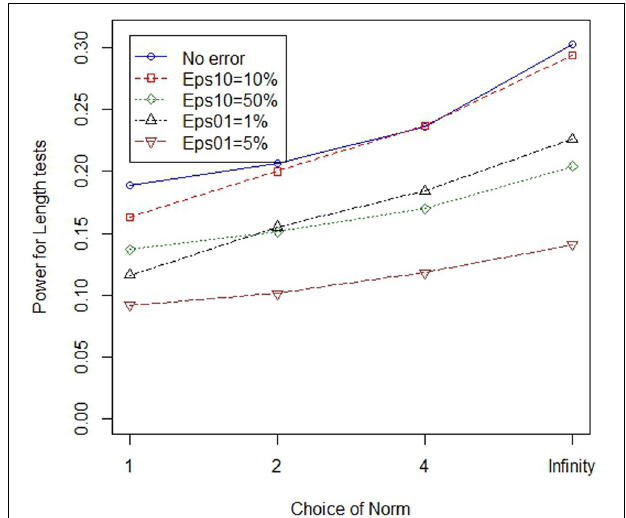
FIGURE 3 | Higher norms are more robust to genotype errors when the proportion of non-causal variants is larger: length tests. The figure illustrates power of four different (norm) length statistics, under varying error models. All test statistics experience power loss in the presence of errors. However, power loss can be mitigated through the use of high norm test statistics.